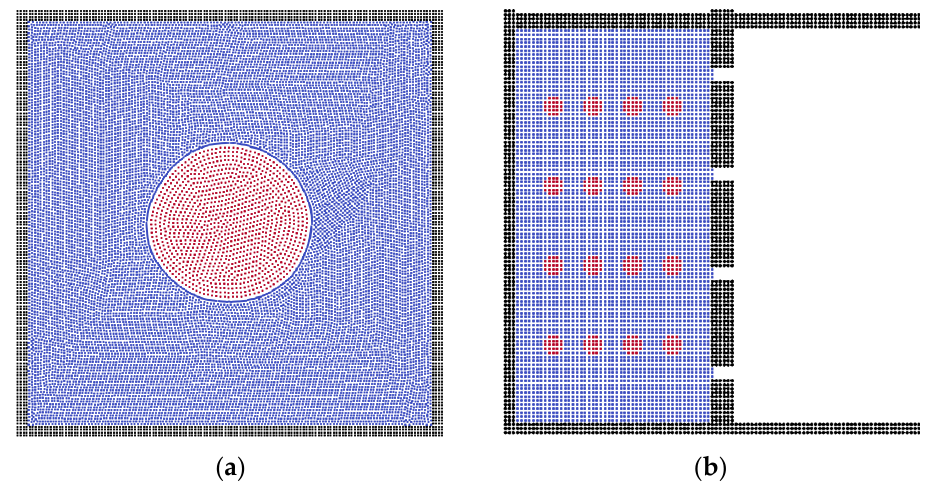
Figure 1. ( a ) The two-phase validation model and ( b ) the physical model of oil–water separation. Black particles represent the solid wall and membrane, blue particles represent the water phase, and red particles represent the oil phase.